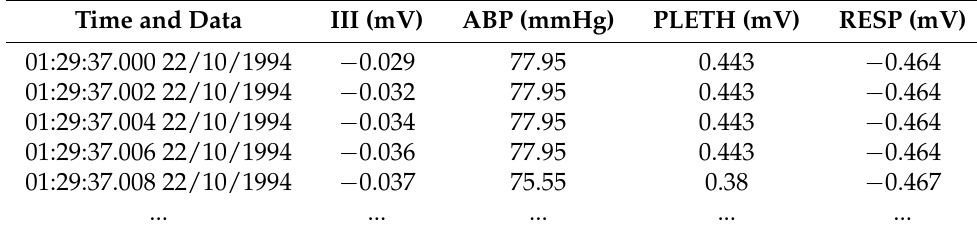
Table 1. Data samples of the MIMIC data set.